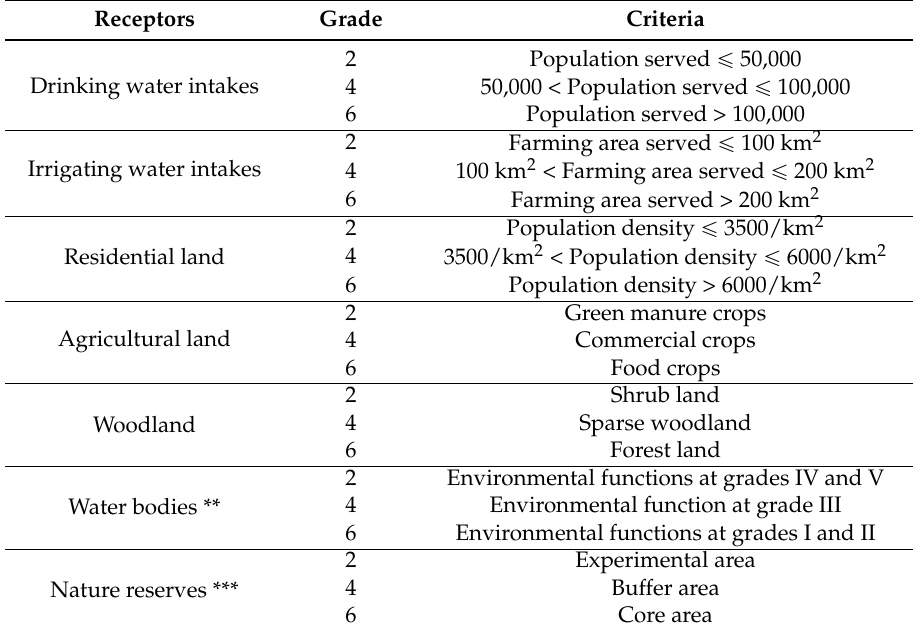
Table 2. Vulnerability ranking criteria for risk receptors *.